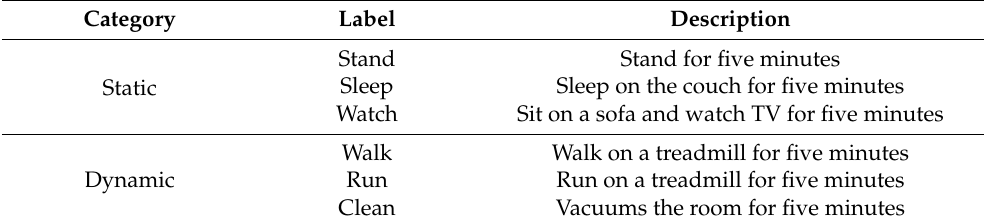
Table 1. The description of the dataset.